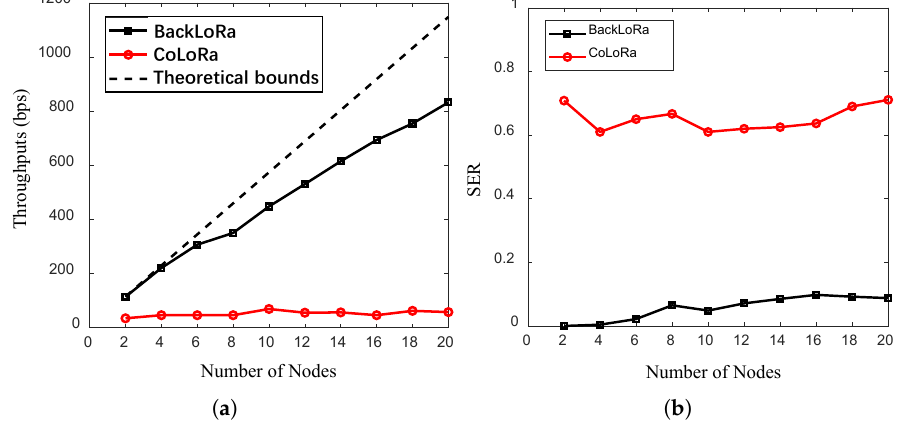
Figure 10. The throughput vs. es (SNR = − 20 dB). ( a ) The throughput with an increasing number of nodes. ( b ) The SER with an increasing number of